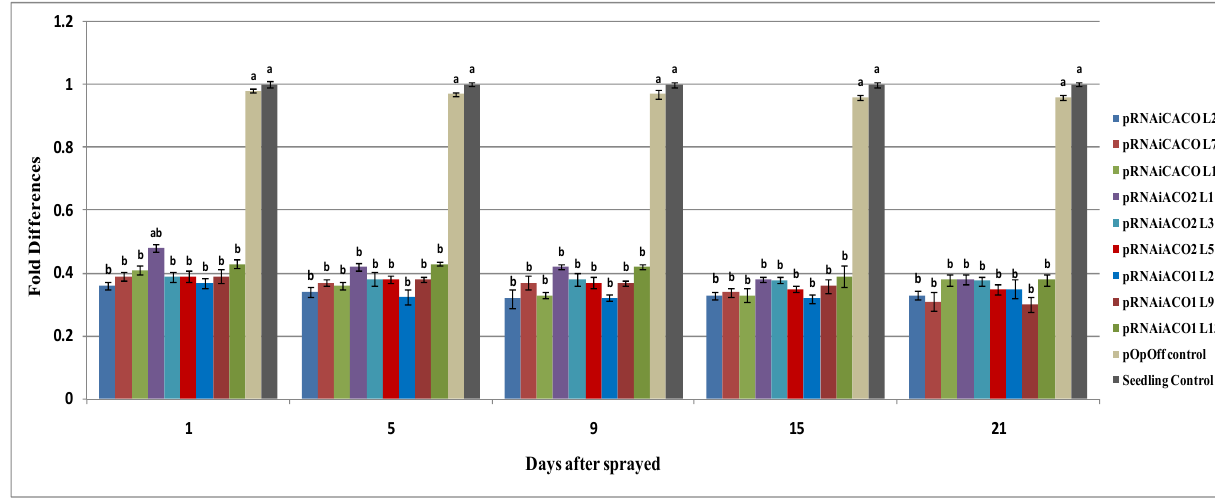
Figure 2. Gene expression analysis of putative transgenic plants harbouring pRNAiACO1, pRNAiACO2 and pRNAiCACO after treatment with dexamethasone. pOp: plant transformed with RNAi pOpOff vector, and Non- transformed control: Seedling-derived non-transformed plant. Duncan multiple range test was used to compare the mean values among the test at 95% probability. Means with the same letters are not significantly different at p < 0.05. n = 3